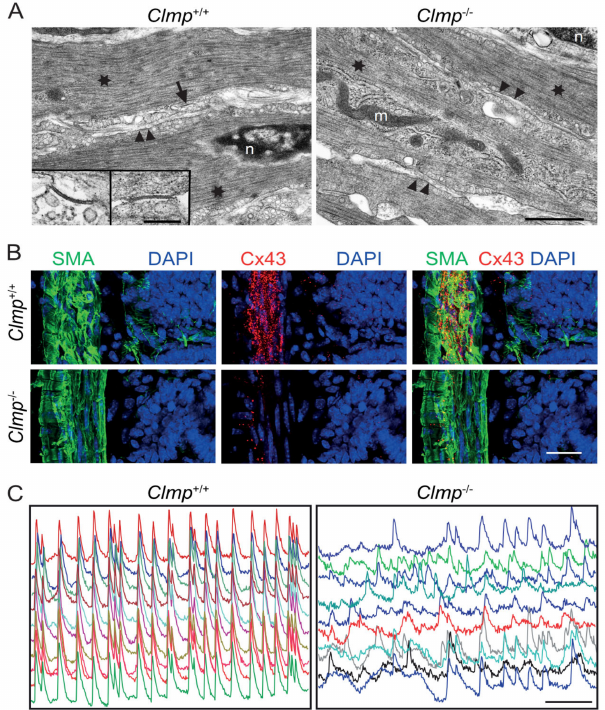
Figure 3. CLMP-deficient mice exhibit a reduction in gap junctions and the expression of connexin-43 in the intestinal smooth muscle layer. ( A ) Electron microscopy reveals a severe reduction in gap junctions in the Clmp − / − . The arrow denotes a gap junction in the wild-type smooth muscle layer, with enlargements shown in the insets. Scale bar, 1 µ m and 200 nm (insert). Arrowheads, plasma membrane; m, mitochondria; n, nucleus; stars, actin-myosin filaments. ( B ) Immunohistochemistry for connexin43 (Cx43) shows a reduction in Cx43 clusters in the circular smooth muscle layer of the intestine in the CLMP-deficient mouse. Scale bar, 20 µ m. ( C ) The absence of CLMP induces uncoordinated calcium waves in the smooth muscle layer of the intestine, which are regulated by gap junctions (modified and reproduced from [15]). Different regions of interest are indicated by different colors. Time scale bar, 100